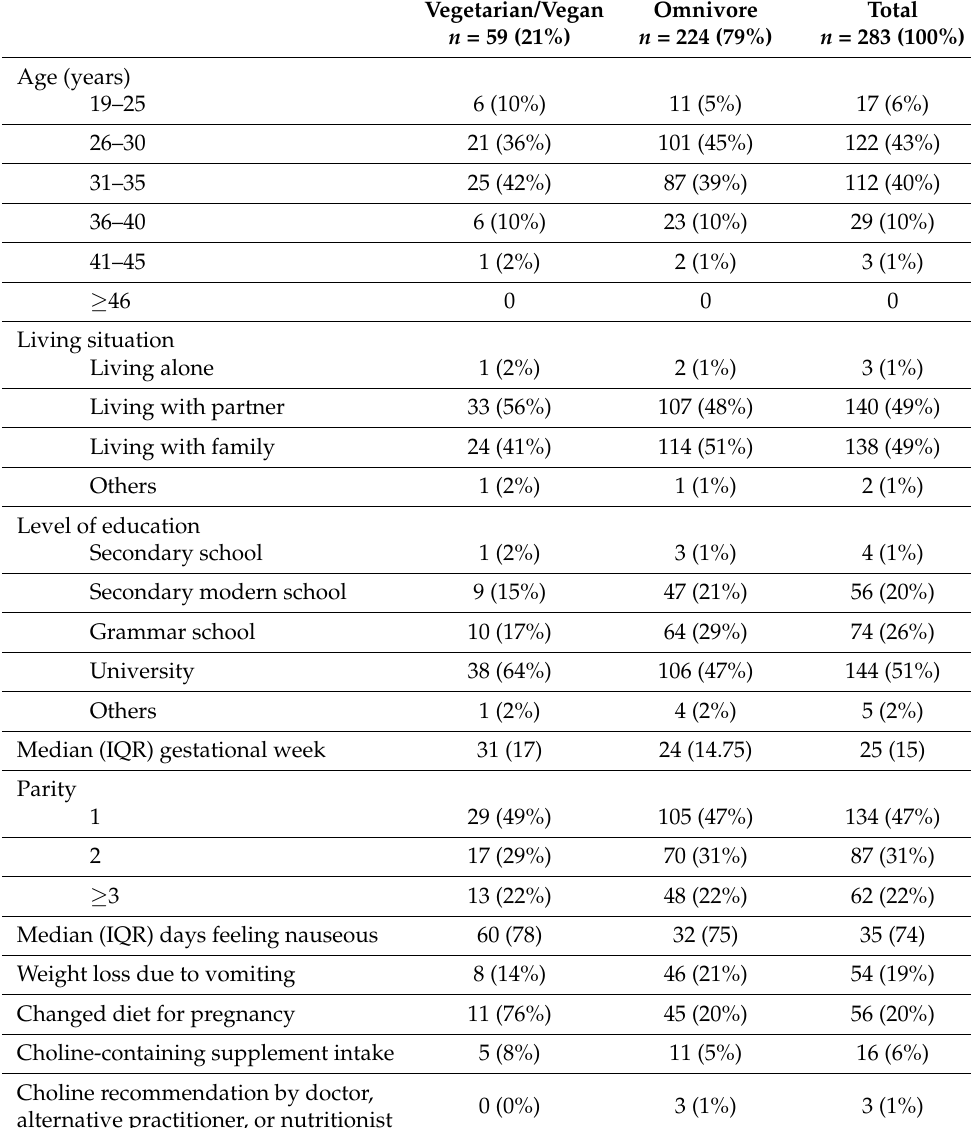
Table 1. Descriptive statistics of the study population. Selected characteristics of the study cohort ( n = 283) stratified by dietary patterns. Values are absolute number and percentages unless stated otherwise within diet group according to the categories in the first